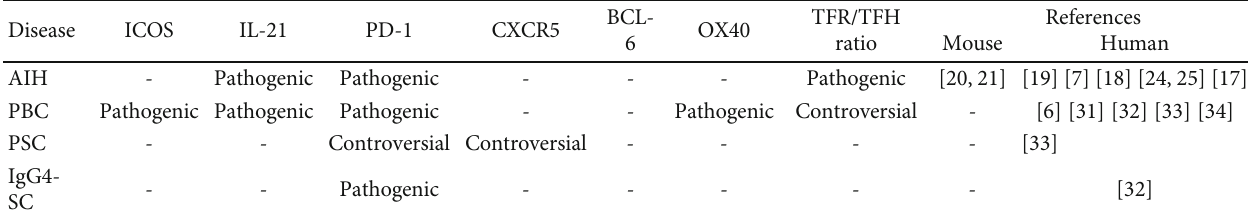
Table 1: In fl uence of follicular helper T cells (TFH) in human and mouse AILDs.